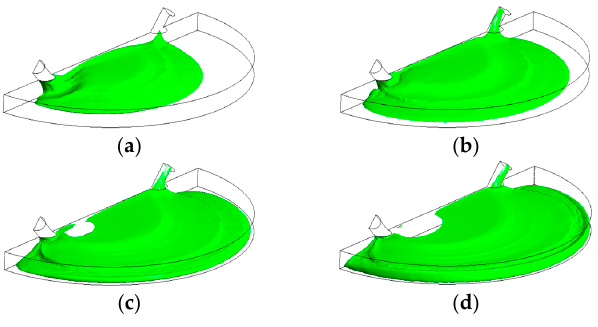
Figure 7. Free-surface during chamber flooding at the following times: ( a ) 0.15 s < τ c ; ( b ) 0.25 s < τ c ; ( c ) 0.38 s ≈ τ c ; ( d ) 0.5 s > τ c , at an inlet liquid flow rate of 500 µL/min ( τ c = 0.385 s).